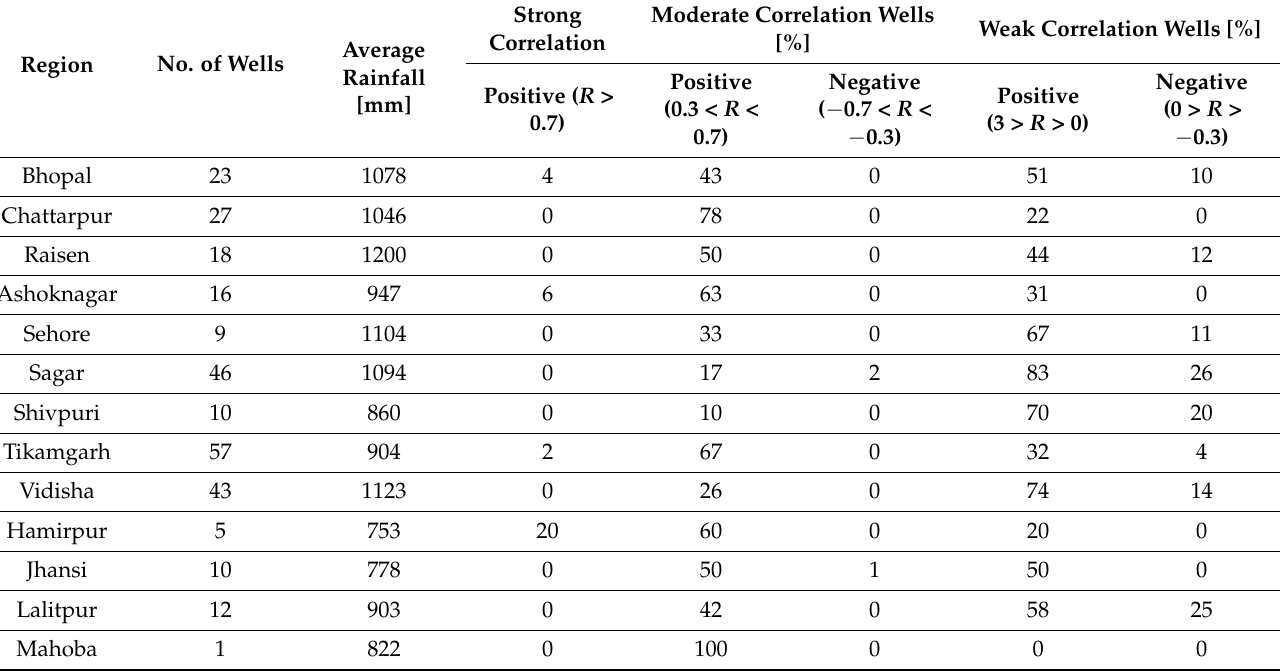
Table A1. The correlation coefficient ( R ) of GWL fluctuation in response to the monsoon rainfall.